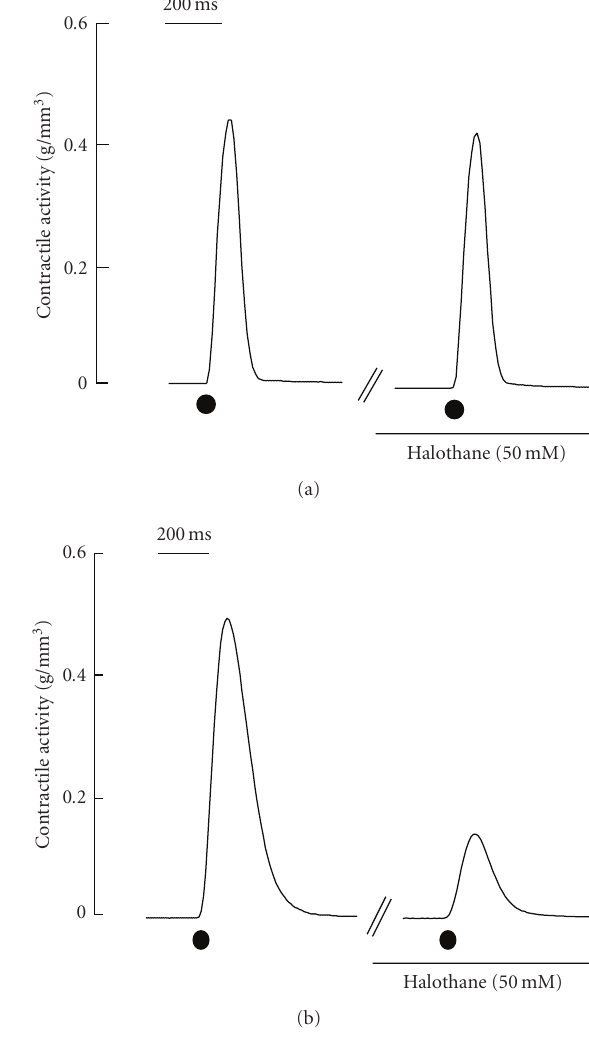
Figure 3: E ff ects of halothane on the contractile responses in esophageal and cardiac muscles. Single-pulse EFS was applied in the absence and presence of halothane (50mM), an inhibitor of gap junctions, and the contractile responses were recorded. Representative traces of esophageal (a) and cardiac (b) muscle preparations are shown. Similar results were reproducibly obtained in four independent